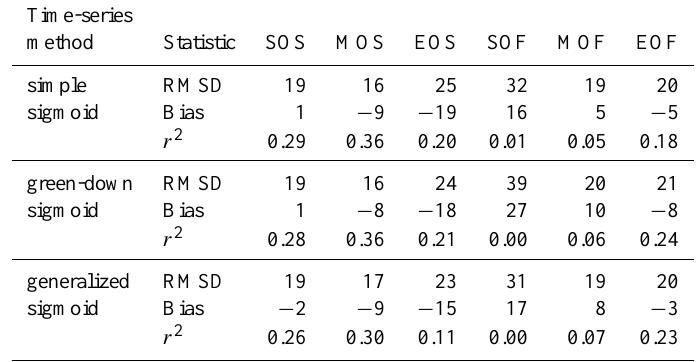
Table 6. Statistics comparing the MEASURES phenology product to near-surface imagery. Statistics computed as in Table 4.